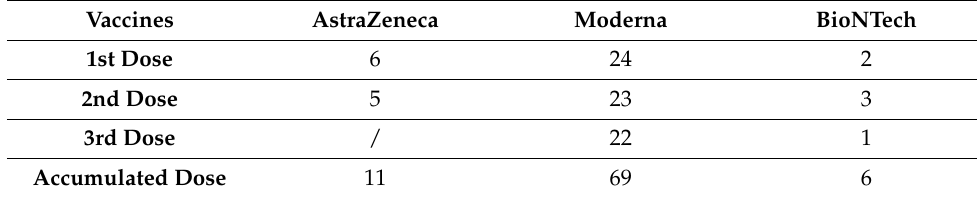
Table 2. Types and vaccinations history in 32 recipients of kidney